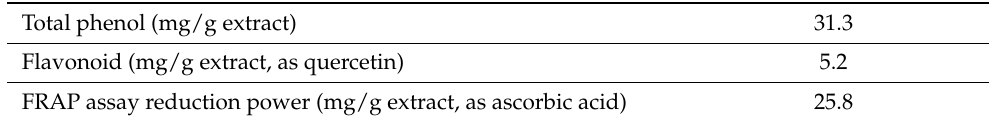
Table 1. The phytochemical analysis of the Asian pigeonwing